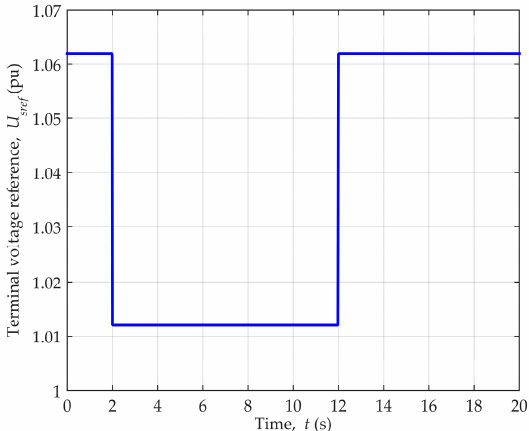
Figure 4. Terminal voltage reference change for generator operating point P = 0.89, Q = 0.41 ind.